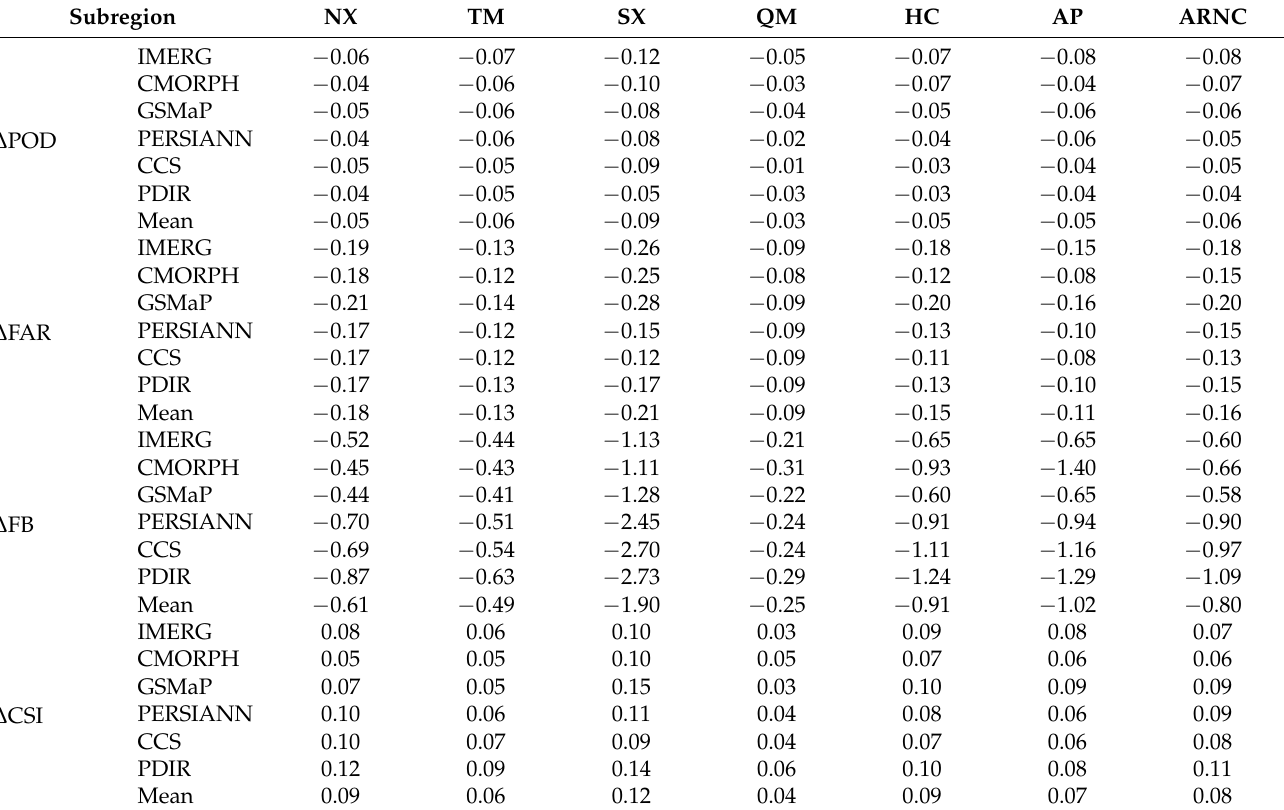
Table 4. The changes of categorical metrics of SPPs in each